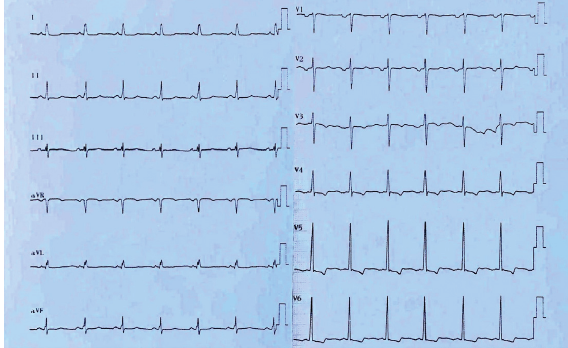
Figure 4: ECG strip showing after cardioversion. The patient’s rhymes were turned into sinus.